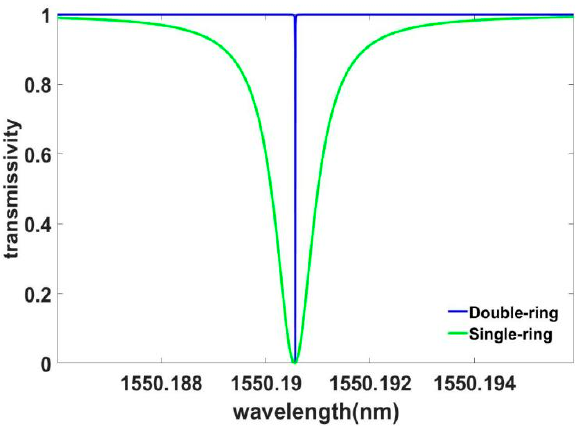
Figure 2. Comparison of resonant peaks of double ring resonator and single ring resonator at the same resonant wavelength. The ring length of the single ring resonator is the same as the inner ring length of the double ring resonator.